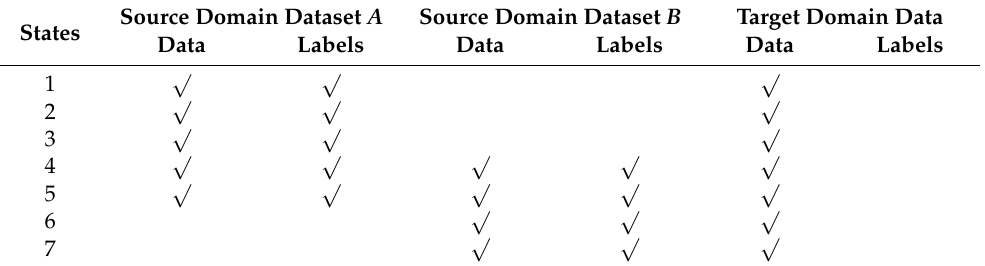
Table 4. Distribution of health states in two source domains and one target domain.